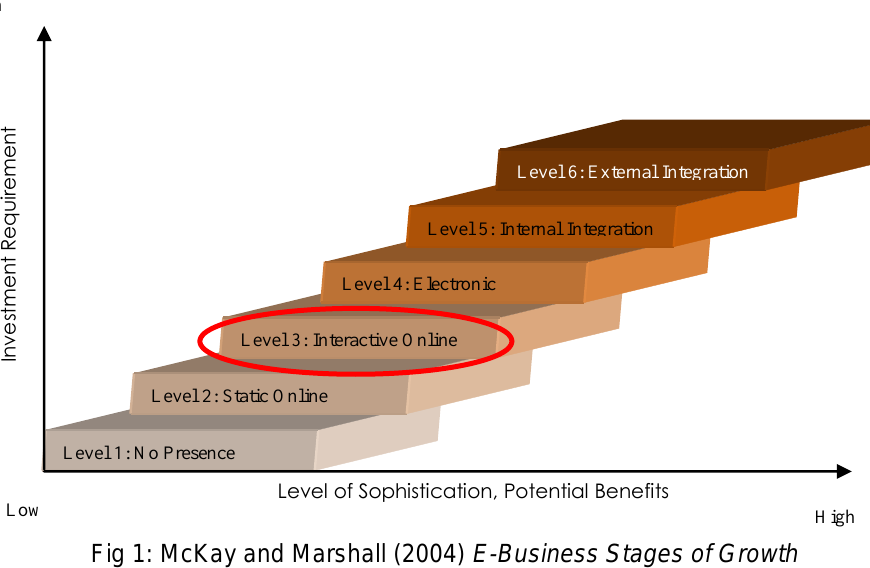
Fig 1: McKay and Marshall (2004) E-Business Stages of